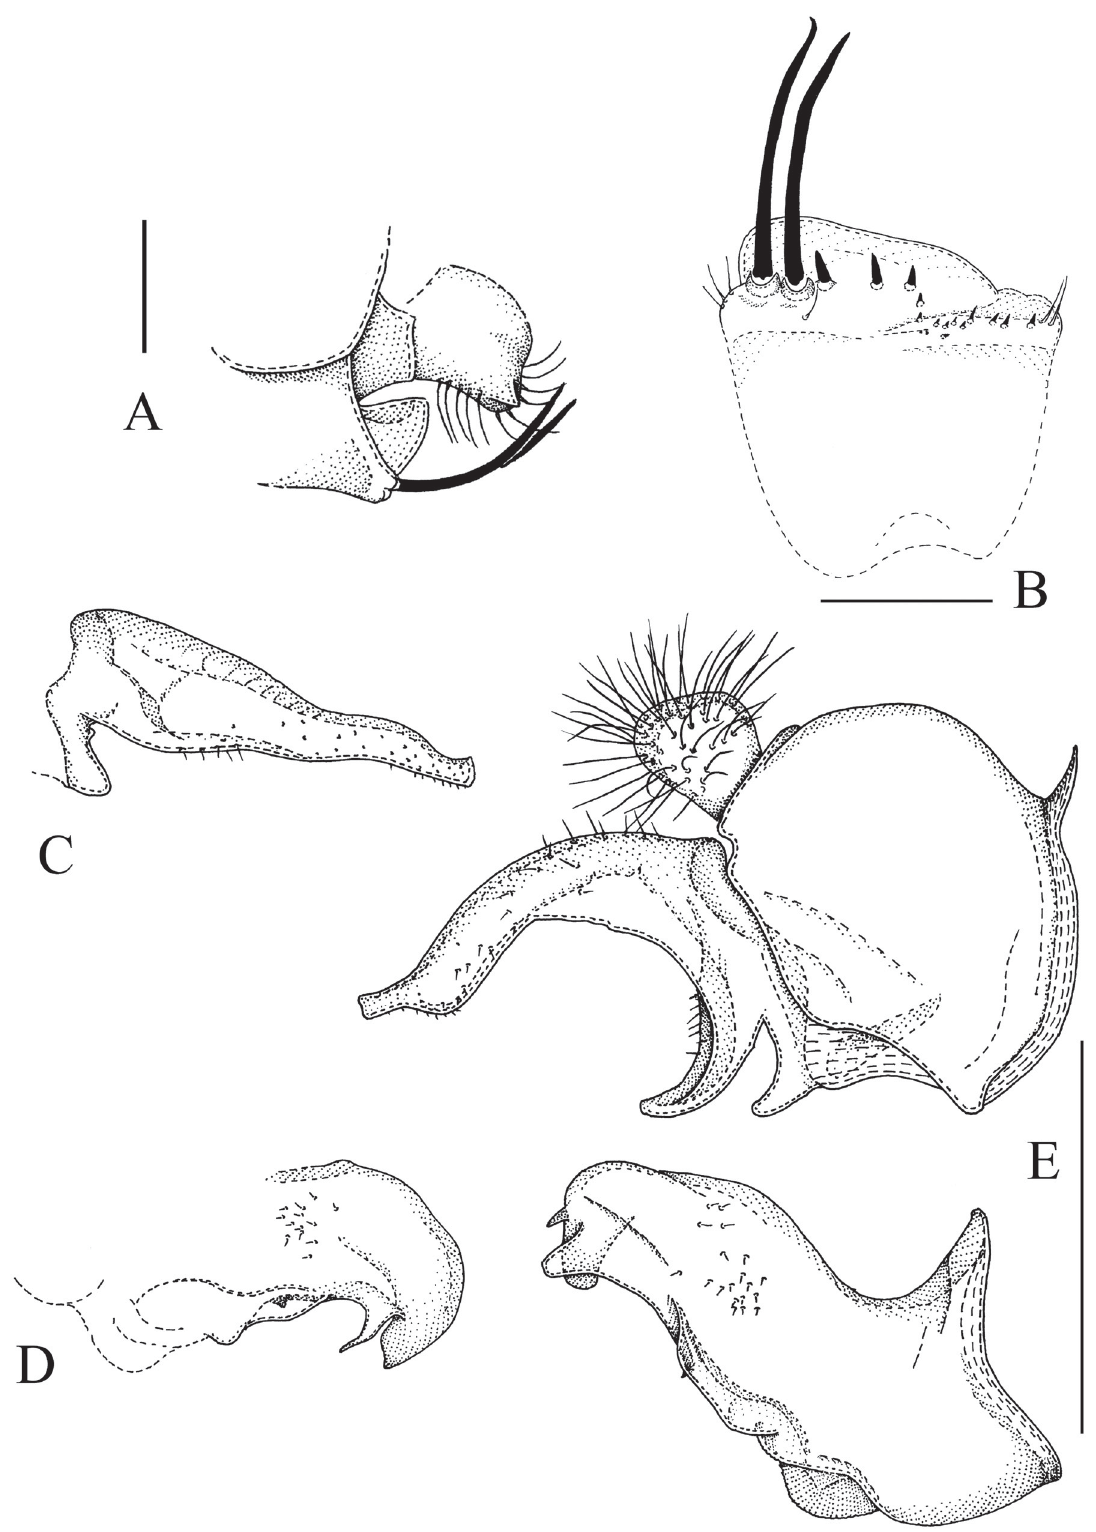
Fig. 34. Sphegina (Asiosphegina) furcillata sp. nov., holotype, ♂ . A . Posterior part of abdomen, left side lateral view. B . Sternum IV, ventral view. C . Left surstylus, lateral view. D . Left superior lobe with associated parts, lateral view. E . Genitalia, right side, lateral view. Scale bars =